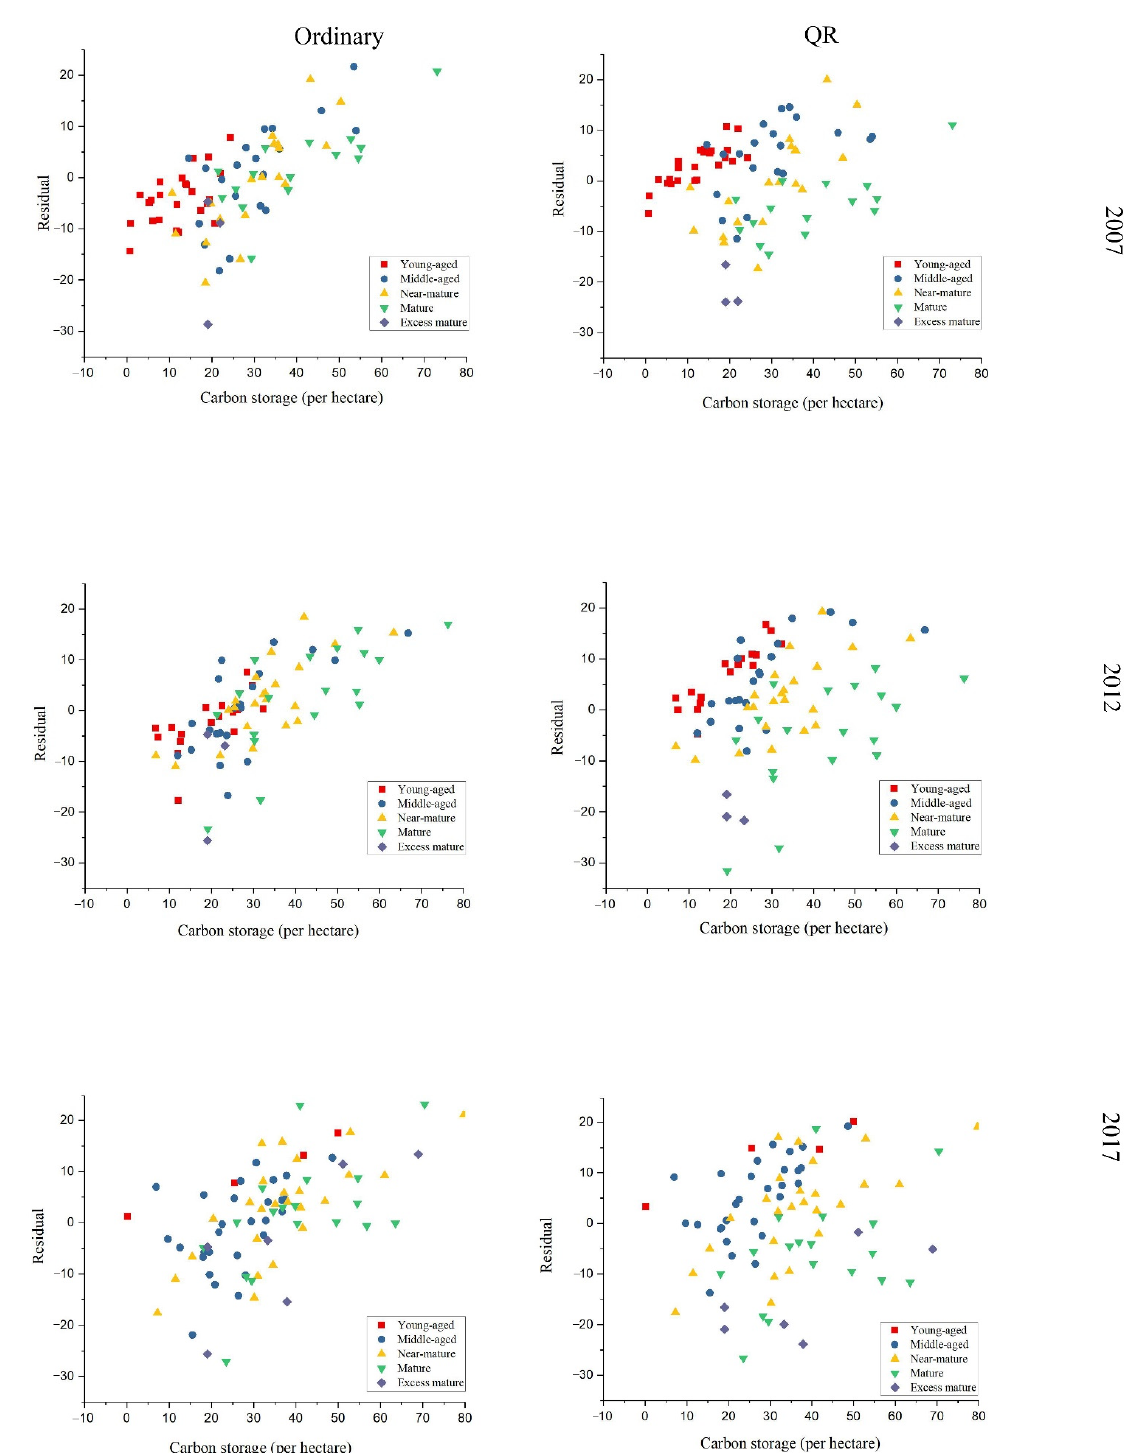
Figure 3. Residual plots of the ordinary model and the quantile